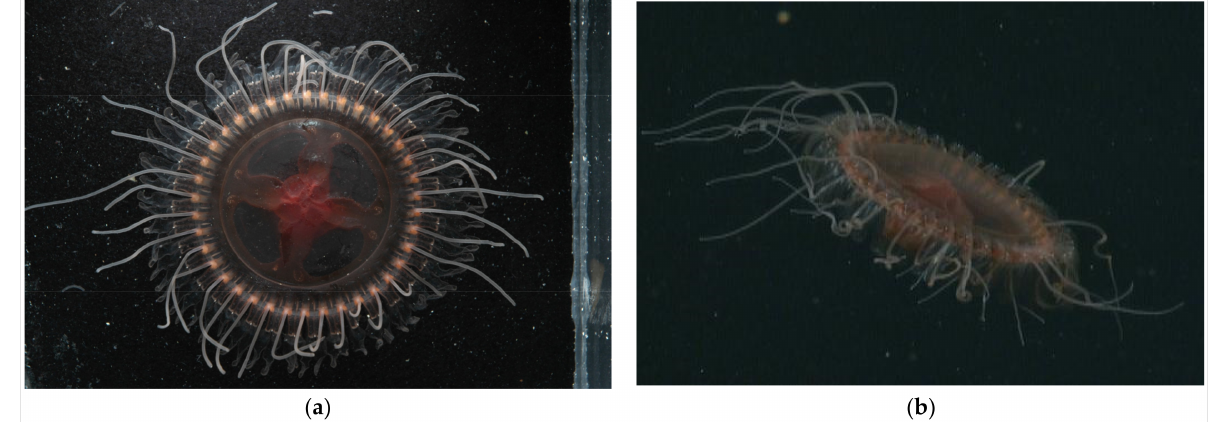
Figure 1. Images of Atolla reynoldsi sp. nov. from T960 on 4 April 2006. ( a ) Laboratory photo of Atolla reynoldsi sp. nov. (photo by Rob Sherlock). Diameter from margin to margin (excluding lappets) is 8.5 cm and tentacles were coiled in situ. ( b ) In situ image of Atolla reynoldsi sp. nov. The spikes and spike ridges on the lappets and the coiled tentacles are visible.